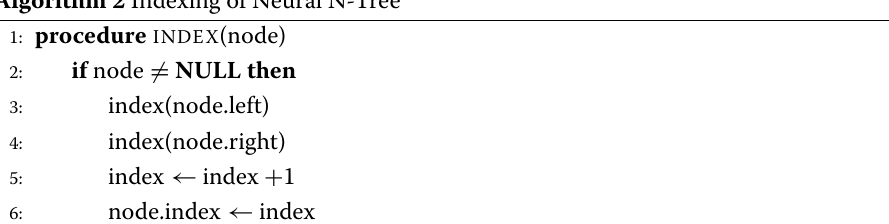
Algorithm 2 Indexing of Neural